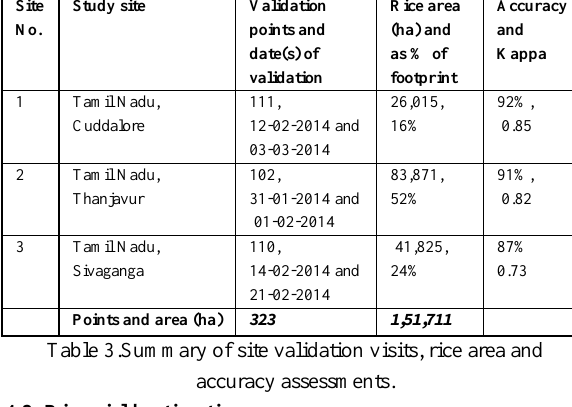
Table 3.Summary of site validation visits, rice area and accuracy